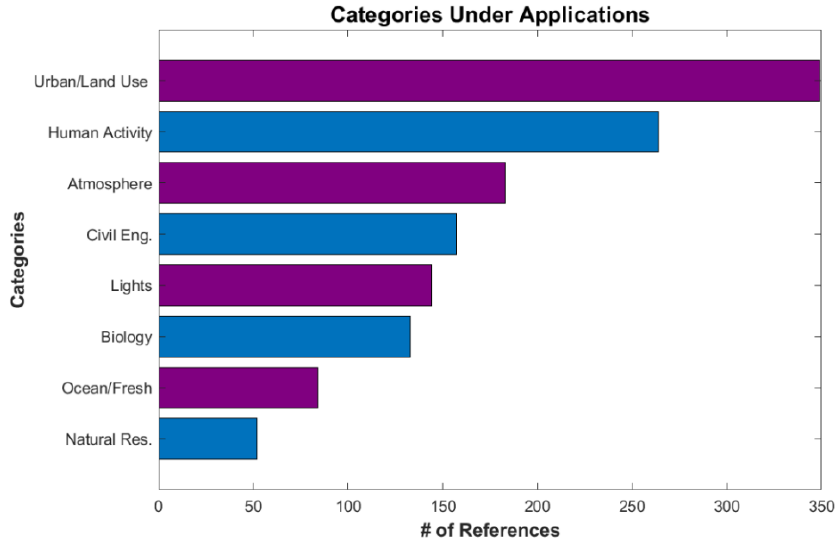
Figure 5. The number of references for each subcategory tag under Applications.